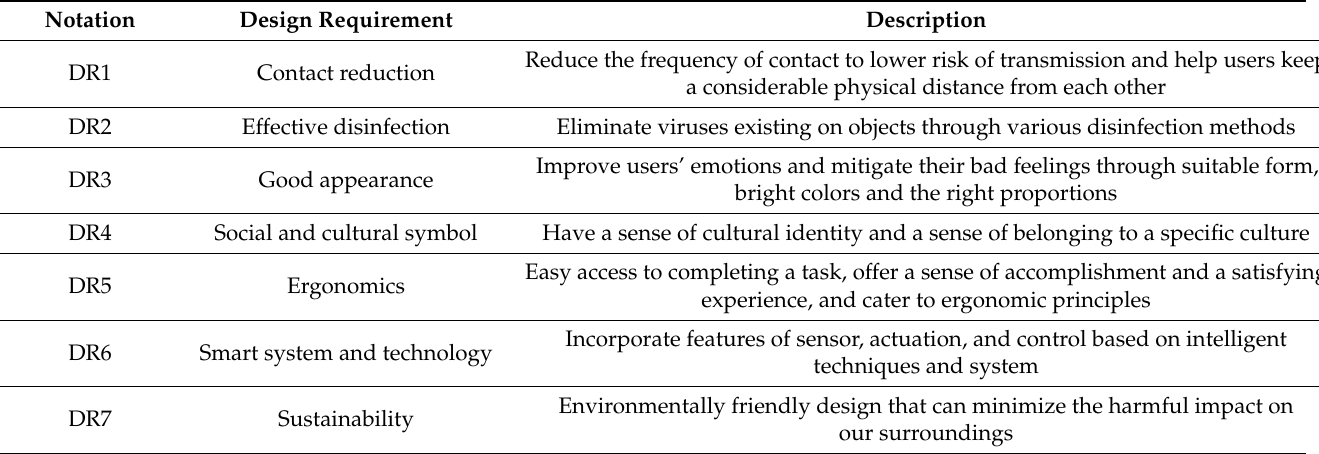
Table 5. Design requirements (DRs) of urban furniture design for pandemic prevention and control.